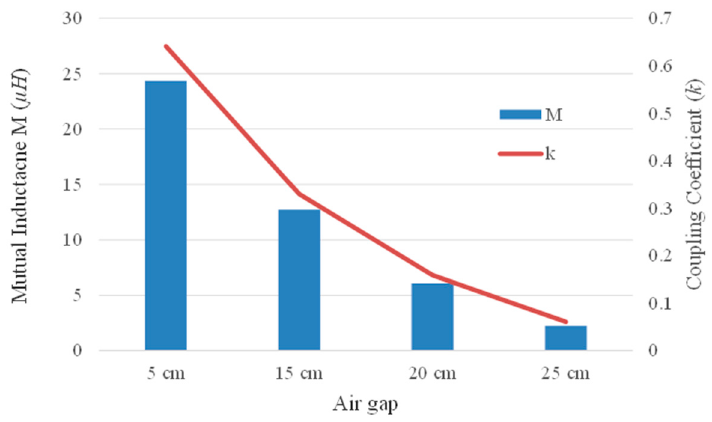
Figure 7. Mutual inductance and coupling coefficient of QDQ coils.